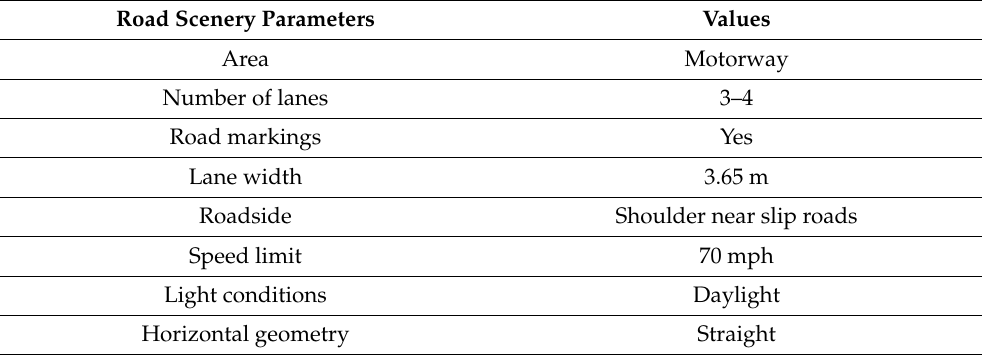
Table 2. Simulation parameter setup related to the scenery.